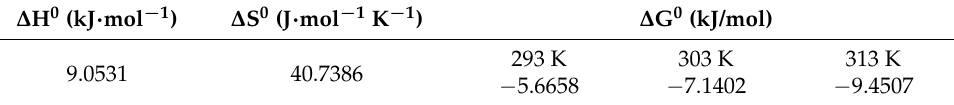
Table 9. Thermodynamic parameters for Se(IV) removal by nZVI/rGO composites.